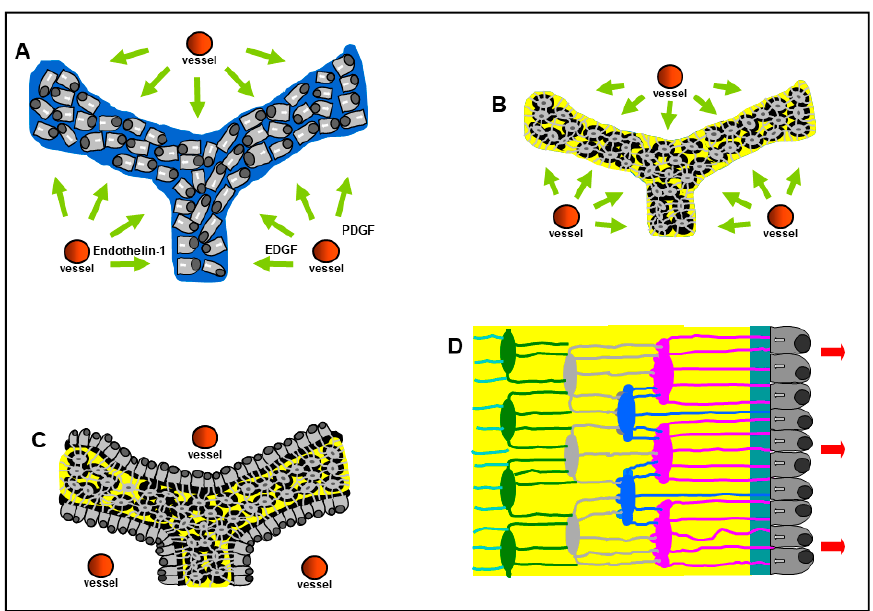
Figure 3. Schematic drawing showing the occurrence, in sequence, of static (SO) and dynamic (DO) osteogenesis. In SO, stationary osteoblast cords ( A ) differentiate at about half distance between two vessels, giving rise to big globous osteocytes ( B ), often located inside confluent lacunae, with short and symmetrical dendrites. In DO, osteoblastic laminae differentiate on the surface of SO ‐ derived trabeculae ( C ) and transform into small spidery osteocytes ( D ) whose asymmetrical dendrites form in concomitance with the migration of the osteogenic lamina. See text for explanation. (EDGF: endothelial ‐ derived growth factor; PDGF: platelet ‐ derived growth factor). Among all osteocytes (both SO ‐ and DO ‐ derived) and between osteocytes and oste ‐